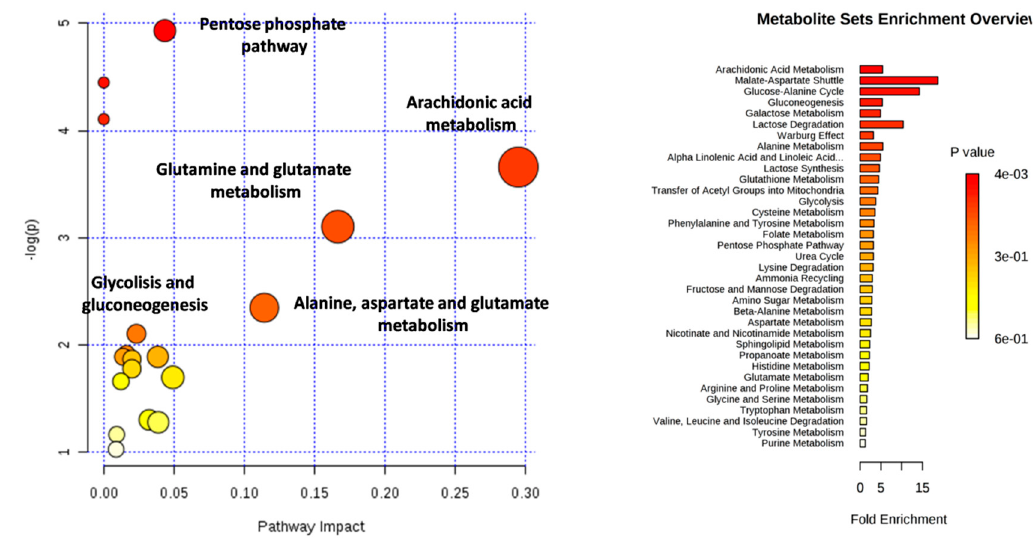
Figure 3. Altered pathways in chorionic villi samples affected by β -thalassemia resulting from the analysis with Metaboanalyst.